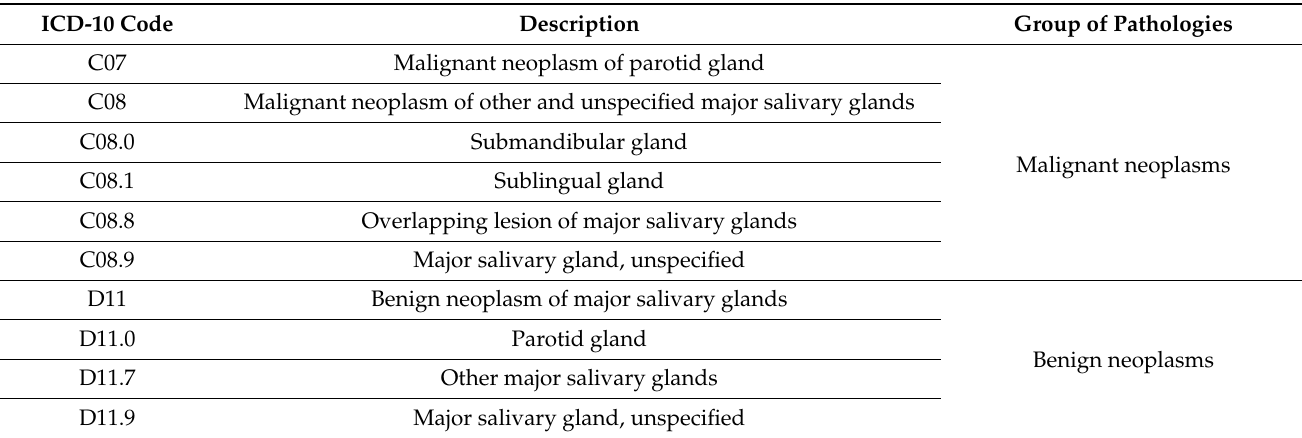
Table 1. Analyzed codes of salivary gland diagnosis according to the ICD-10 classification, with descriptions and division into three types of pathologies: malignant, benign, and